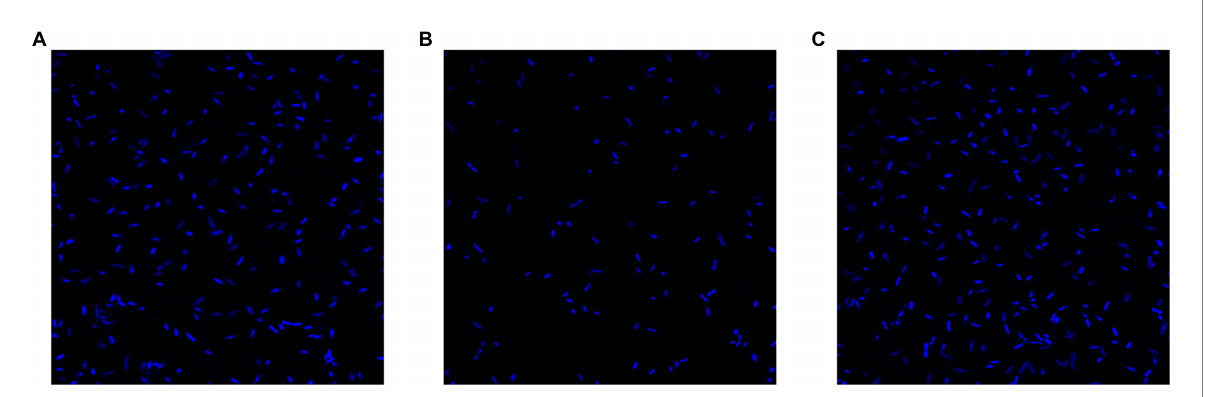
FIGURE 6 LSCM of Escherichia coli K12, E. coli JW5917, and E. coli ReJW5917. (A–C) represent E. coli K12, E. coli JW5917, and E. coli ReJW5917, respectively.